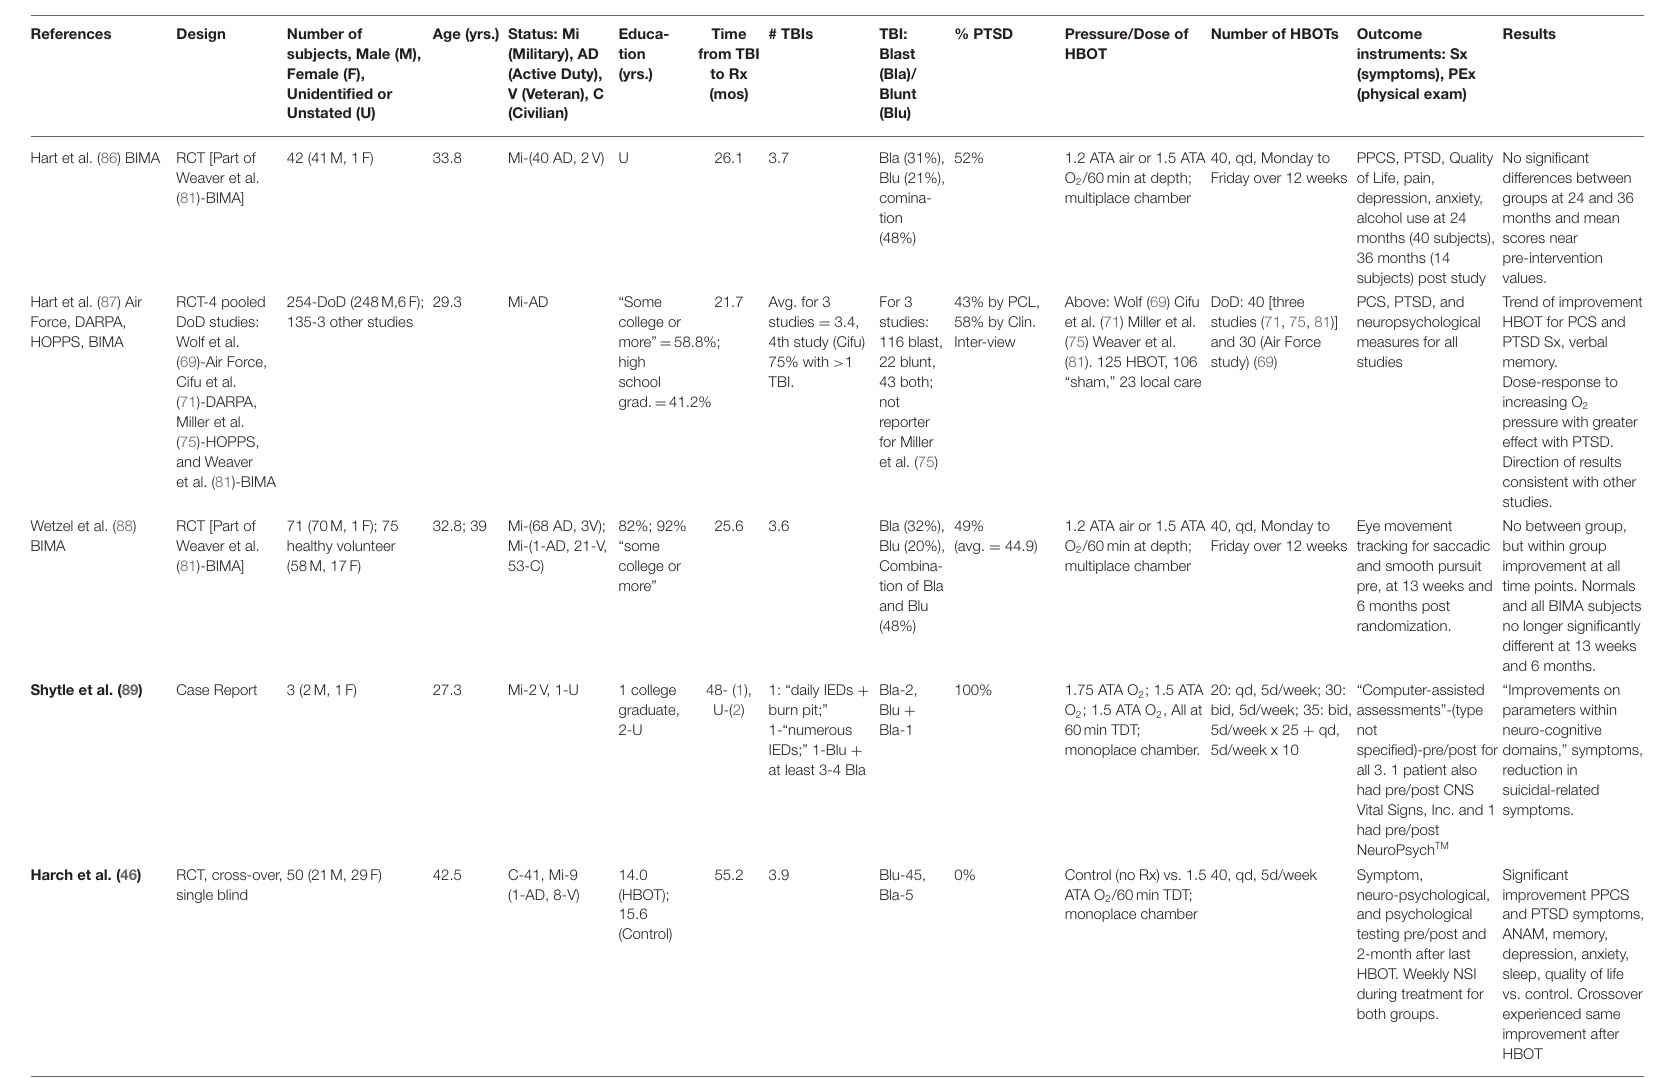
Final analysis studies in